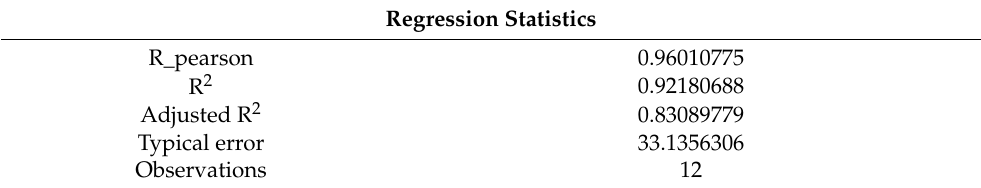
Table 11. Grouped regression statistics of the model analysis.